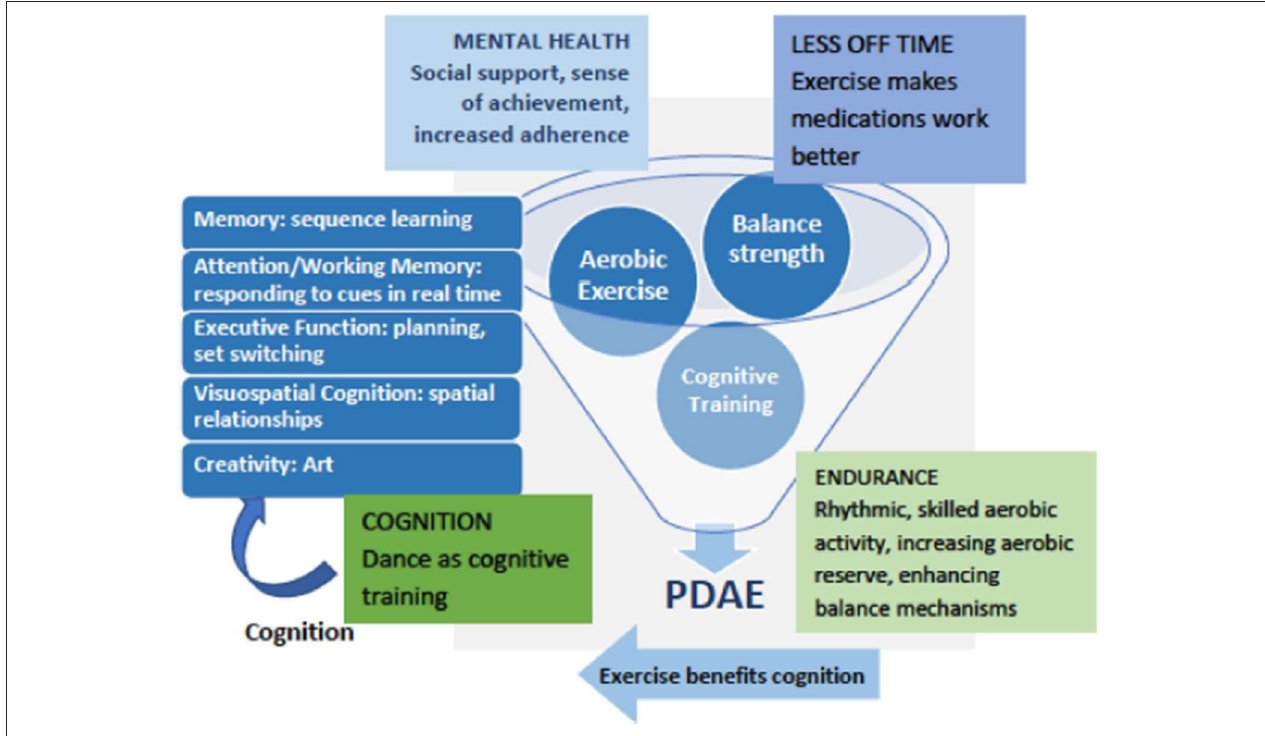
FIGURE 1 | Hypothesized beneficial outcomes of Partnered Dance Aerobic Exercise.